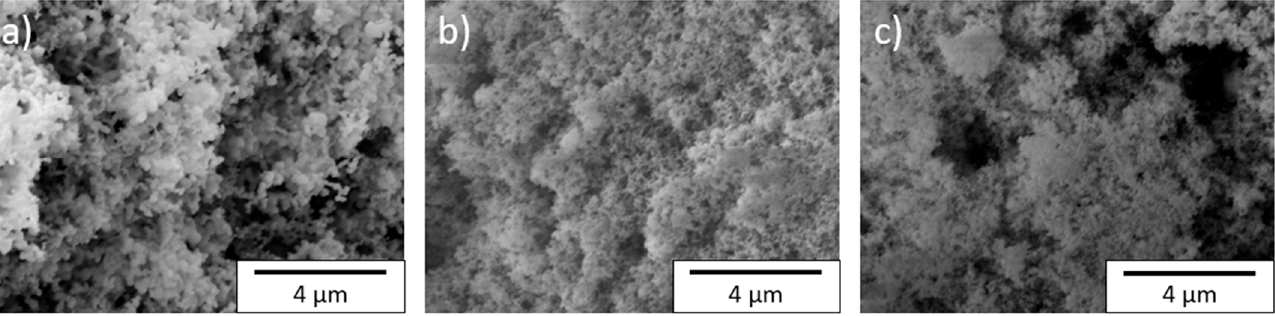
Table 3. Results of chemical analyses for the silicon nanomaterials used, measured by inductively coupled plasma optical emission spectroscopy (ICP-OES), carrier gas hot extraction (CGHE), and carbon and sulfur (CS) analyzer (LoQ: limit of quantification).